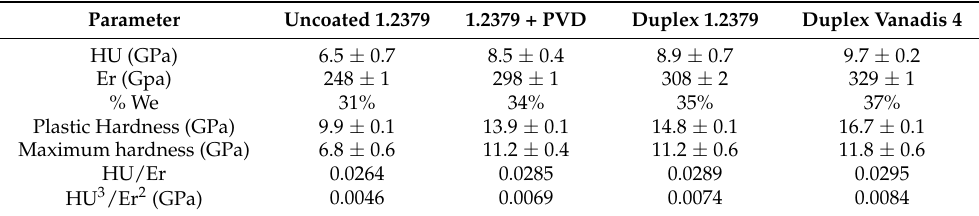
Table 5. Summary of the experimental data derived from the ultra-microhardness tests at 1000 mN: hardness (HU), elasticity (Er), elastic deformation work percentage (% We), plastic hardness, maxi- mum hardness, and H/Er and H 3 /Er 2